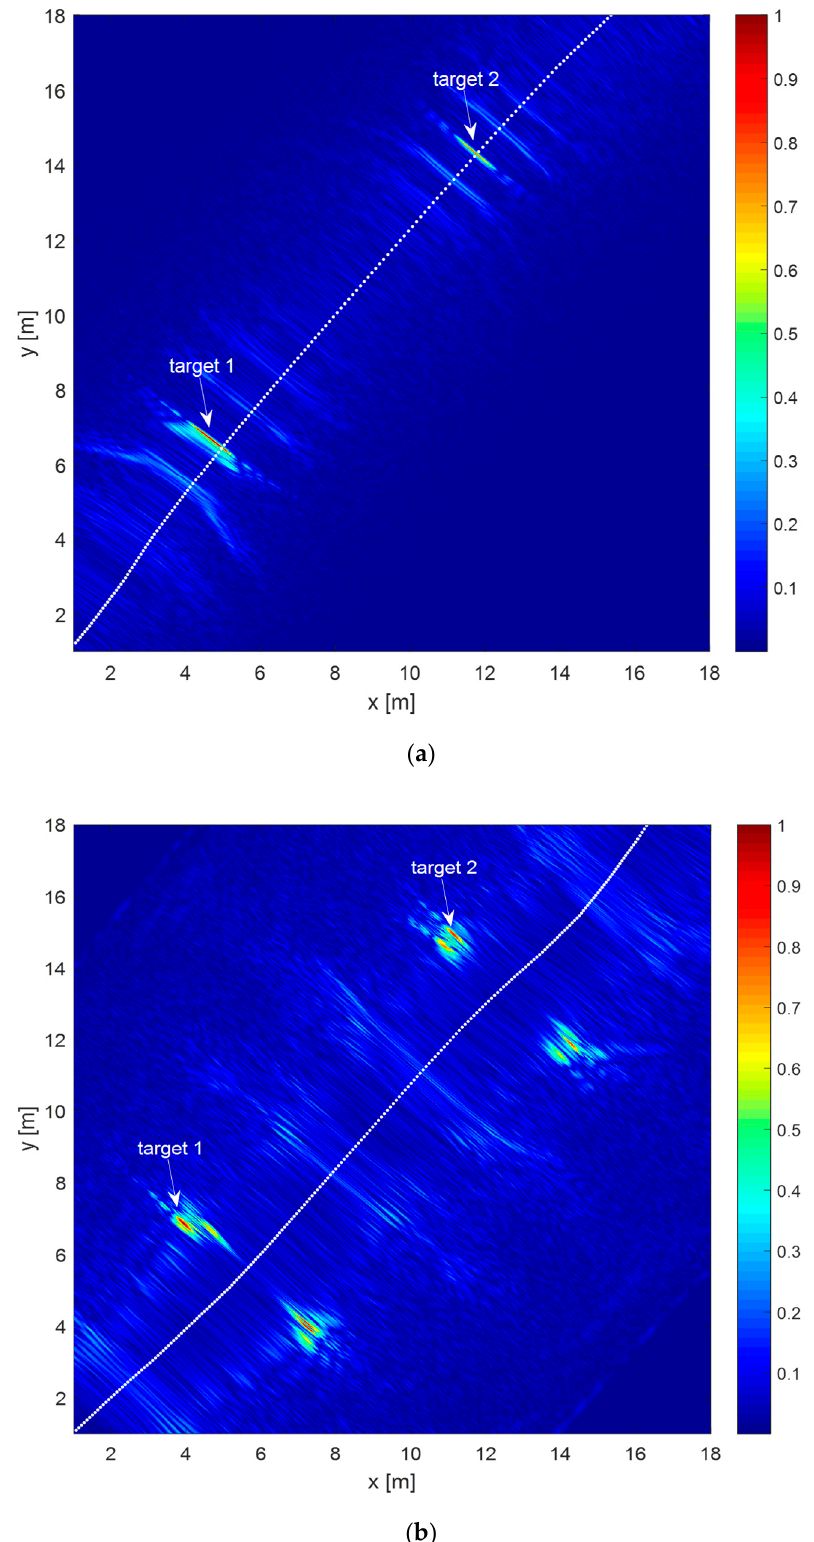
Figure 12. Focused image of the scenario under test: ( a ) Track 1; ( b ) Track 2. The dotted white line represents the flight path as projected onto the investigated domain.